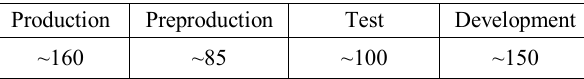
Table 1. URLs served by the